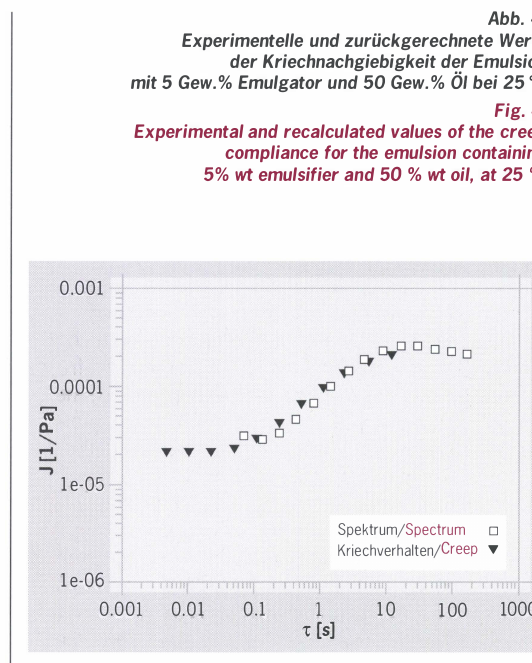
Fig. 5: Retardation spectrum, calculated from creep and dynamic tests, for the emulsion containing 5 % wt emulsifier and